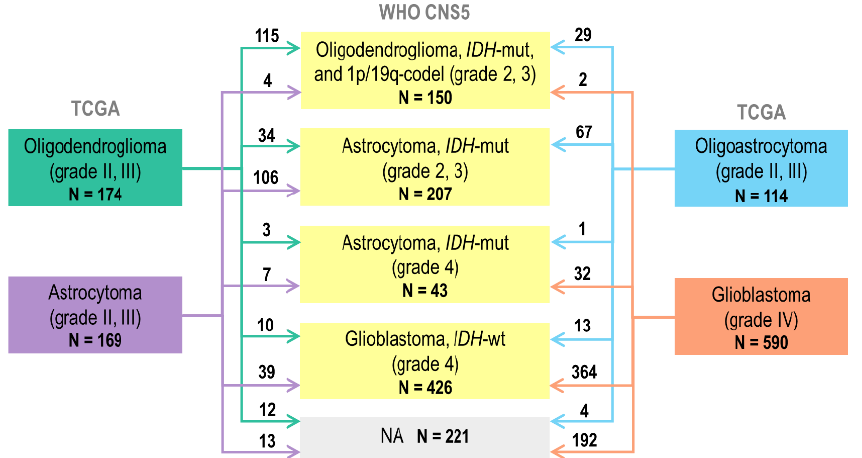
Figure 3. Distribution of TCGA glioma cases according to the WHO CNS5 criteria. Only cases with known histology reviewed (n =